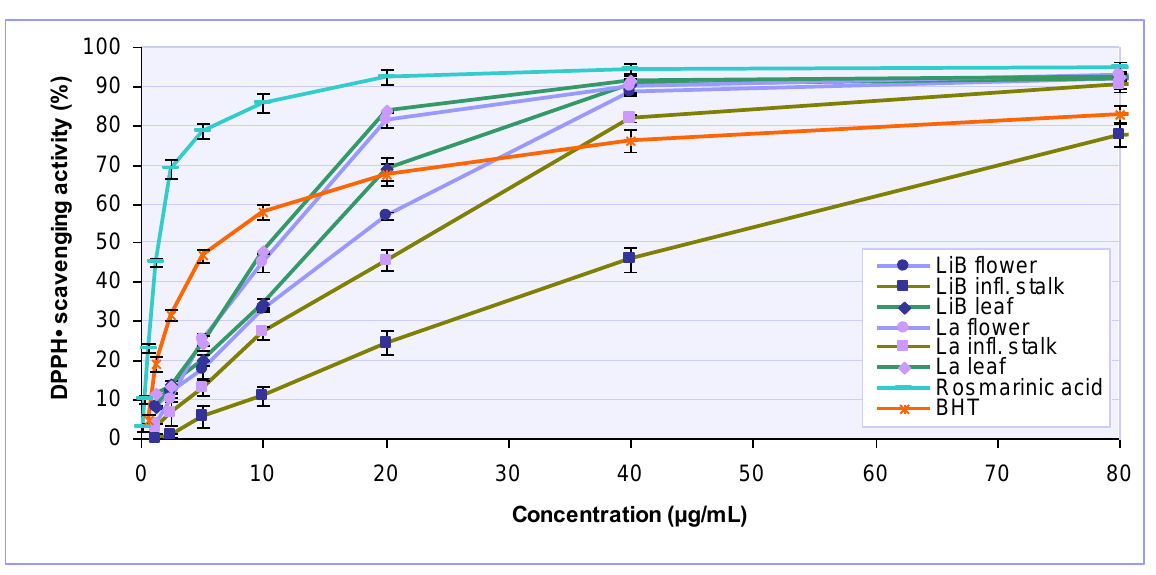
Figure 2. DPPH free radical scavenging activity of various Lavandula x intermedia 'Budrovka' (LiB) and L. angustifolia (La) extracts as well as rosmarinic acid at different concentrations. BHT was used as